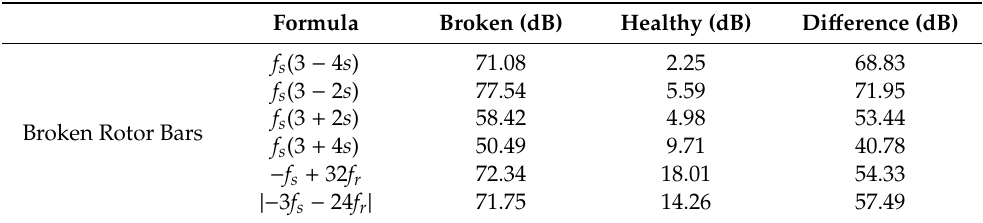
Table 9. Results of harmonics amplitude measurements of the characteristic frequency for a rotor cage fault, obtained from FEM simulations.